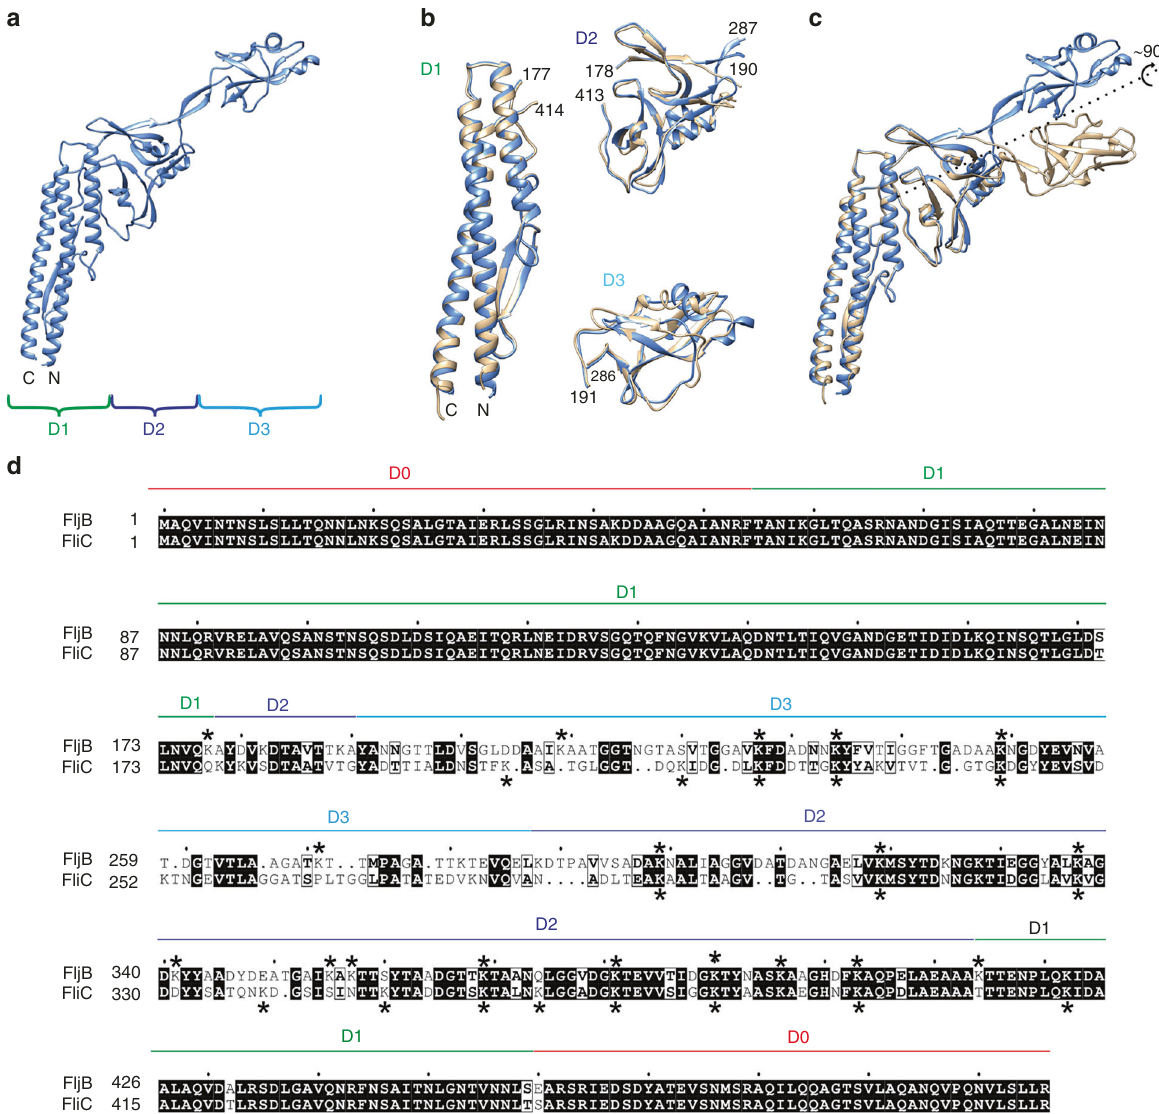
Fig. 1 Structure of FljB and methylation pattern of the fl agellins FliC and FljB. a Cartoon representation of the structure of truncated FljB. The position of the N- and C-termini is shown at the end of the coiled-coil, and the extension of the domains D1, D2, and D3 is indicated below the structure. b Structural superposition of the individual domains. FljB domains are represented in blue, FliC in beige. The N- and C-termini of the structure are indicated, as well as the FljB numbering of the residues at the ends of the polypeptide segments de fi ning the domains. c The structures of truncated FljB (blue) and truncated FliC (beige) have been superposed according to the D1 and D2 domains. The domain D3 shows a rotation of about 90° around an ideal axis starting from one end of the coiled-coil in D1 and passing through D2 (shown as dotted line). d Alignment of FljB and FliC and methylation pattern. Residues of domains D1, D2, and D3 have been aligned based on the structural superposition obtained with the EBI PDBeFold v2.59 server (51), either superposing the D1 – D2 domains or the D3 domain. Residues of domain D0 have been aligned based on the sequence. The extent along the sequence of the domains is indicated above the alignment. Methylated lysine residues are indicated with stars above or below the alignment for FljB or FliC,